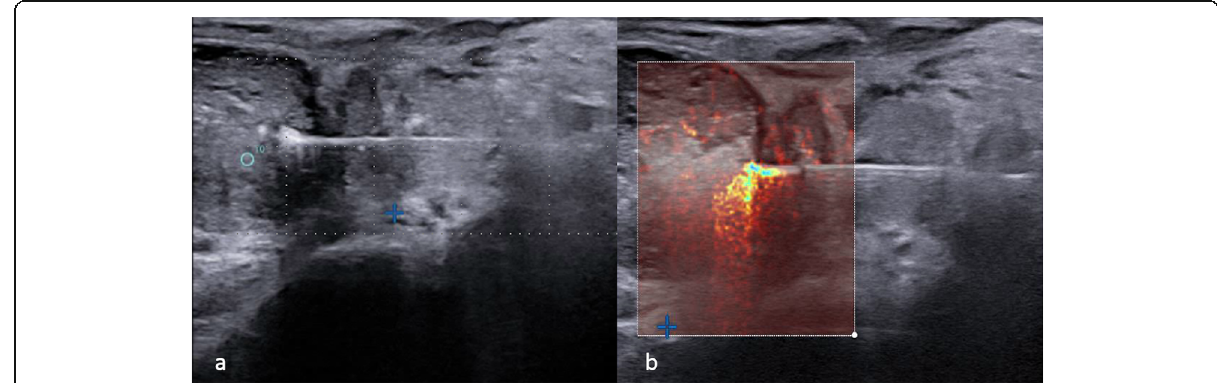
Fig. 1 a Transrectal ultrasound imaging of transperineal laser ablation with gas bubble formation during the procedure. b Power Doppler imaging with Doppler effect related to water molecule movement into the ablated